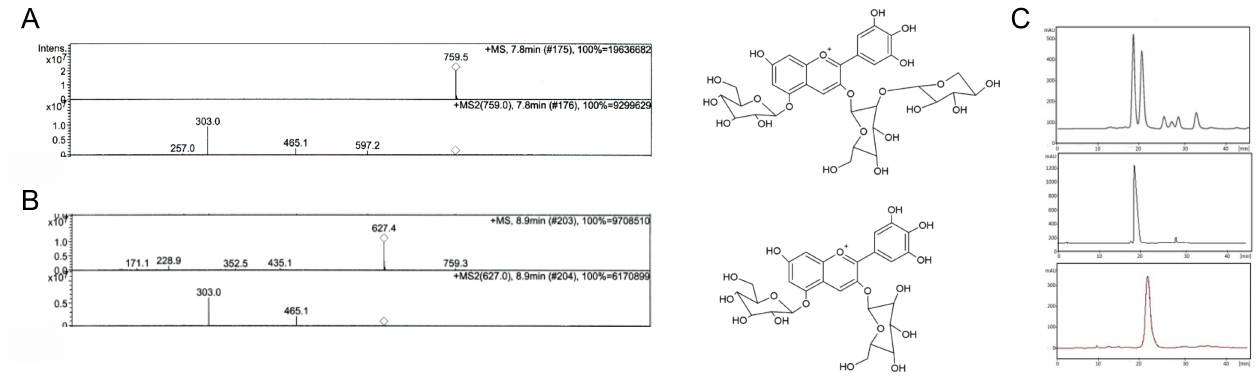
Figure 1. Maqui anthocyanins DS and DG characterization by mass spectroscopy. ( A ) MS spectrum of delphinidin 3- O - sambubioside-5- O -glucoside isolated by CPC: m / z 759.5 MS-MS m / z 597.2, 465.1, 303. ( B ) MS-MS spectrum of delphinidin 3,5- O -diglucoside isolated by CPC: m / z 627: MS-MS m / z 465, 303. ( C ) LC/UV chromatogram crude extract (upper panel), DG (middle panel), DS (lower panel) at λ 520